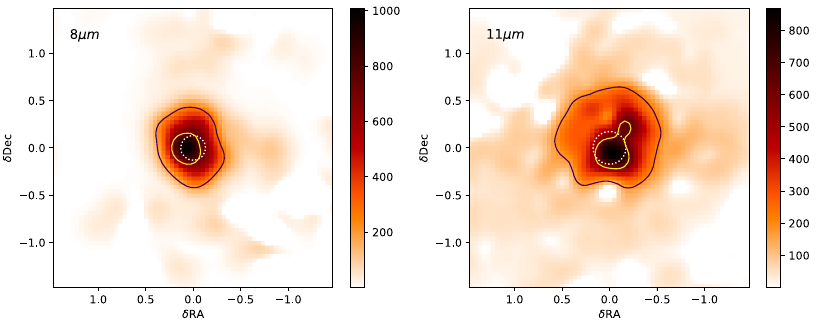
Figure 1. VISIR/Very Large Telescope (VLT) deconvolved images of II Lup at 8 µ m ( left ) and 11 µ m ( right ) in squared-root intensity scale. The resolution element is indicated by the dotted, white circles in the core of each image, while the black and yellow contours indicate the 5% and 50% levels of the peak intensity, respectively. North is up and east is to the left. The colour bars indicate a relative intensity scale.